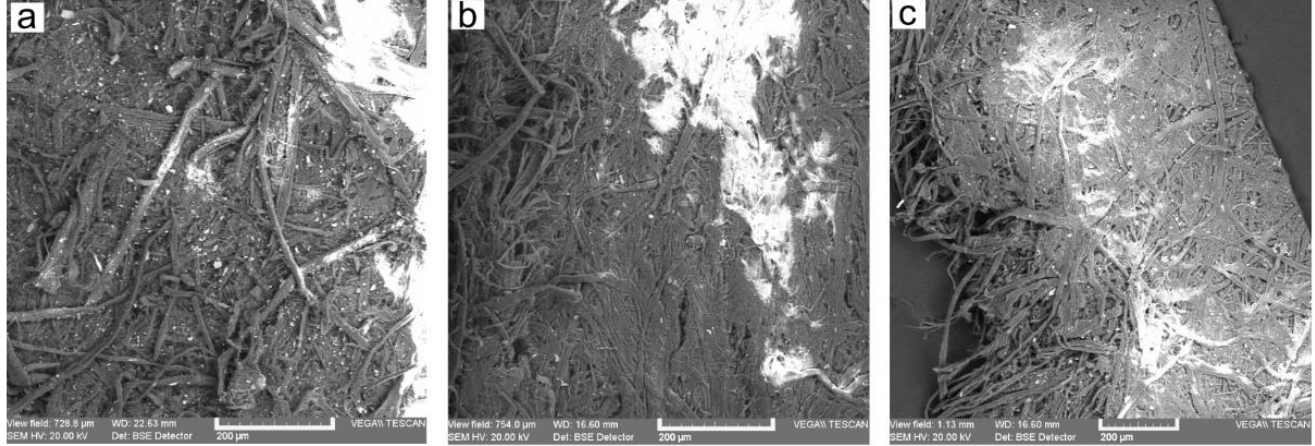
Figure 6. SEM microphotographs of the analyzed documents: ( a ) S1 (×500), ( b ) S2 (×300), ( c ) S3 (×200).